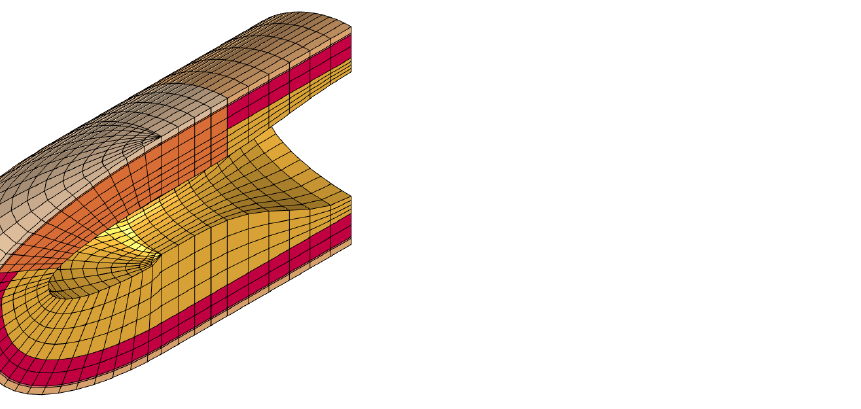
Figure 3. A section view of the finite element model that resulted from the convergence analysis; it consists of 11,637 nodes and 10,080 elements.